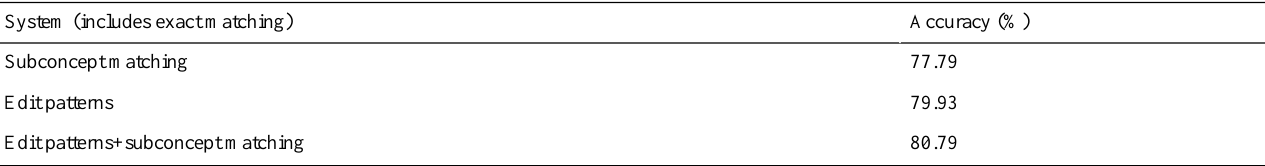
Table 4. Results showing the impact of the subconcept matching component of the system.